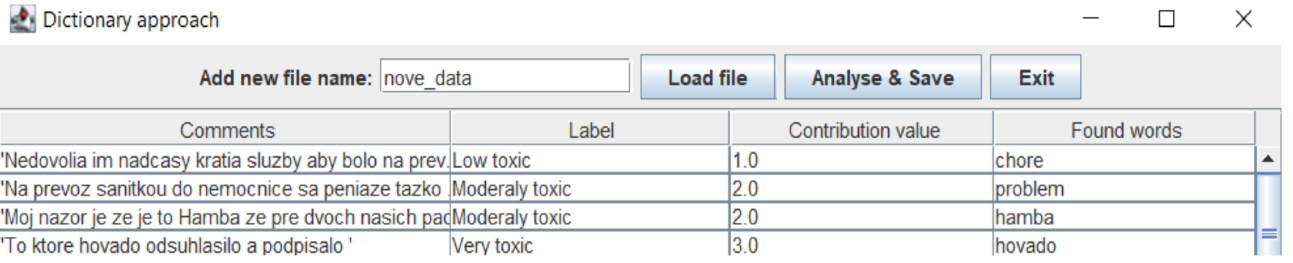
Figure 8. The illustration of results of the lexicon-based analysis of comments from the selected and loaded file.